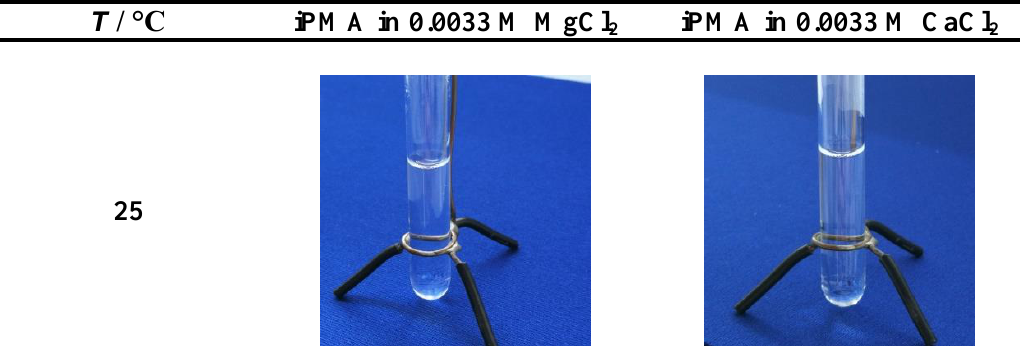
Table S4. Visual observations of iPMA ( c CaCl at 25 2